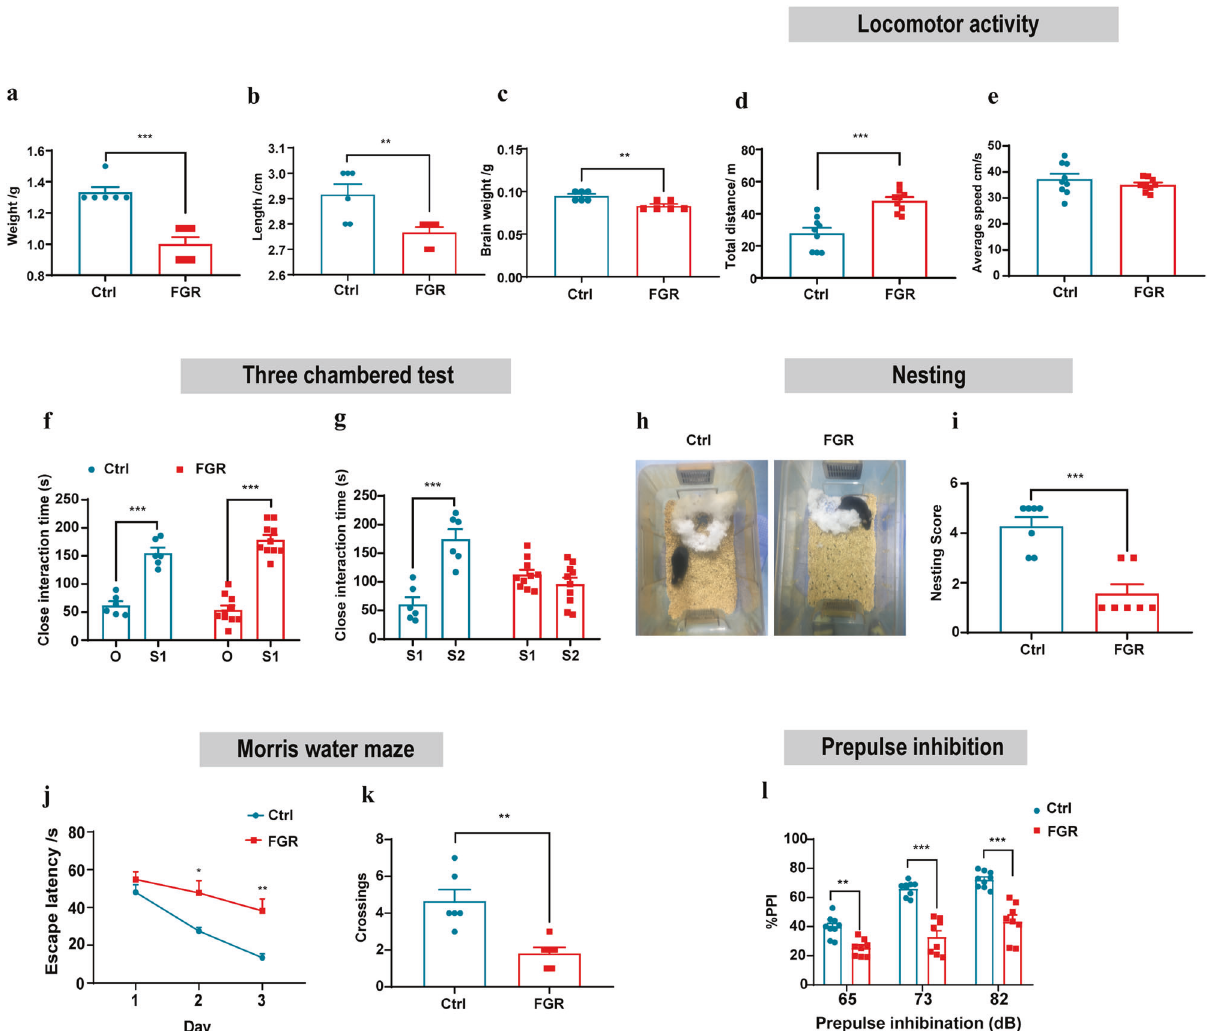
Fig. 1 FGR leads to schizophrenia behavioral defects. a – c Weight, length and brain weight of neonatal mice. n = 6 in each group, weight of control and FGR mouse, unpaired t test, P < 0.001; length of control and FGR neonatal mice, unpaired t test, P < 0.01; brain weight of control and FGR neonatal mice, unpaired t test, P < 0.01. d , e Locomotor activity of control ( n = 10) and FGR ( n = 10) mice. d Total distance, unpaired t test, P < 0.001. e Average speed, unpaired t test, P = 0.328. f , g Three chamber test of control ( n = 6) and FGR ( n = 10) mice. f Time spent on close interaction with an object (O) versus stranger mouse (S1) in the social approaching test. Two-way ANOVA, P Control < 0.001; P FGR < 0.001. g Time spent on close interaction with a familiar mouse (S1) versus stranger mouse (S2) in the social novelty test. Two-way ANOVA, P control < 0.001; P FGR = 0.455. h , i Nest building test of control ( n = 7) and FGR ( n = 7) mice. h Representative pictures of control and FGR nest. ( i ) Nest building score, unpaired t test, P < 0.001. j , k MWM performance of control ( n = 6) and FGR ( n = 6) mice. j Spatial acquisition performance. Two-way ANOVA, P day1 = 0.650; P day2 = 0.011; P day3 = 0.002. k Platform crossing, unpaired t test of target quadrant, P = 0.002. l Prepulse inhibition test of control ( n = 9) and FGR ( n = 8) mice. Two-way ANOVA, P 65db = 0.003; P 73db < 0.001; P 82db < 0.001. The results are expressed as mean ± SD.; * P < 0.05, ** P < 0.01, and *** P <